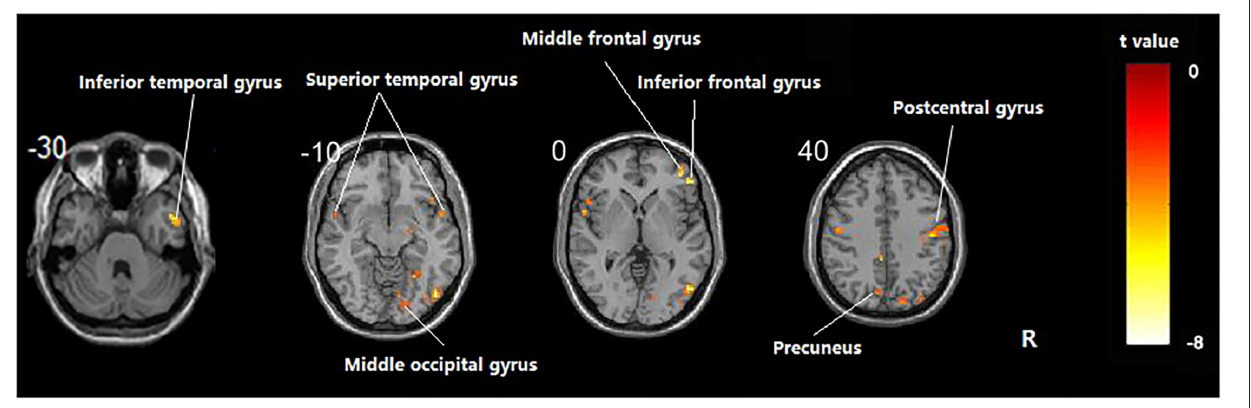
FIGURE 1 | Regions showing significant fALFF value differences between healthy subjects and AD. The results were FDR-corrected with p < 0.05.